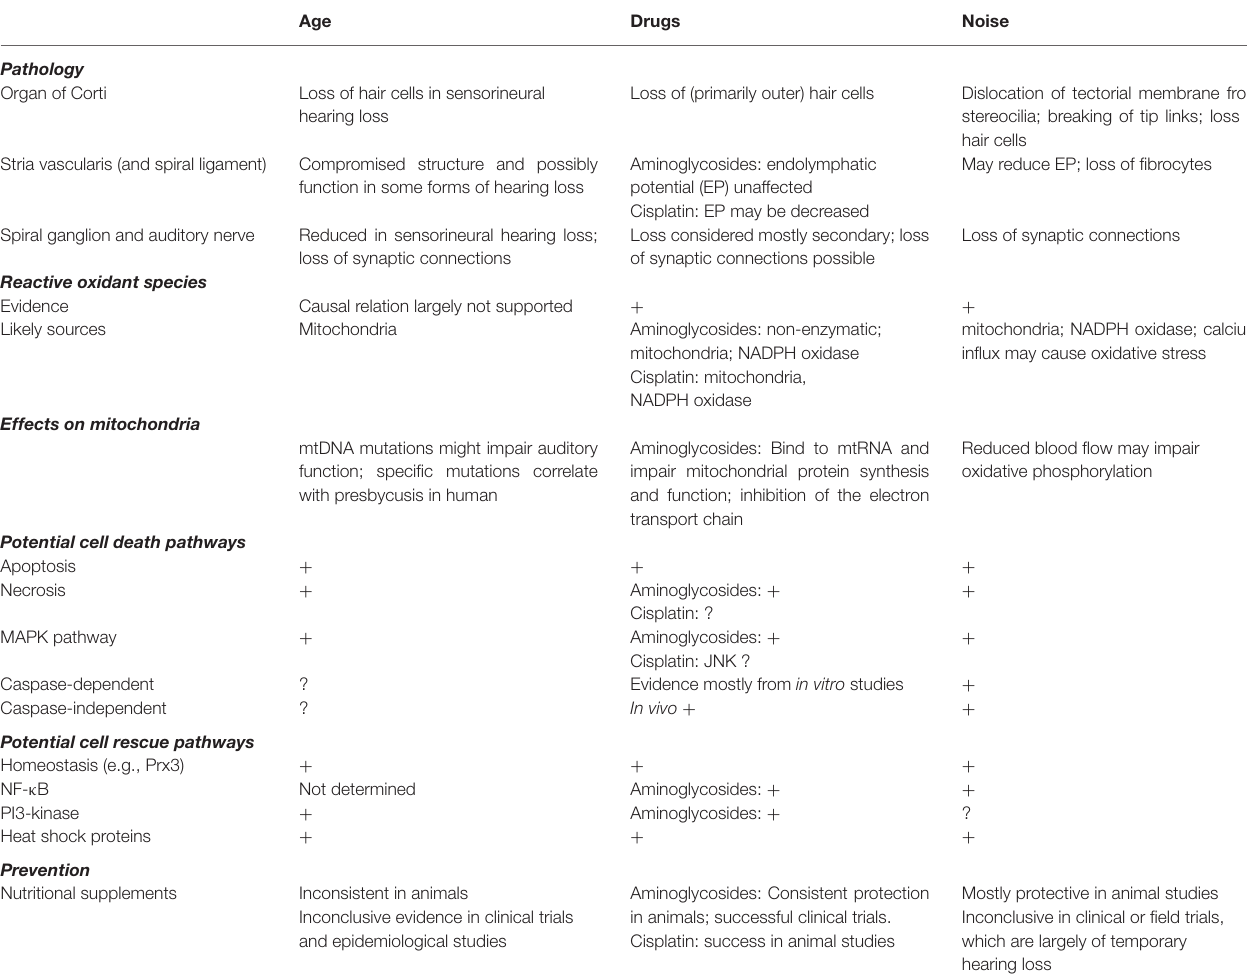
TABLE 1 | Selected features of acquired hearing